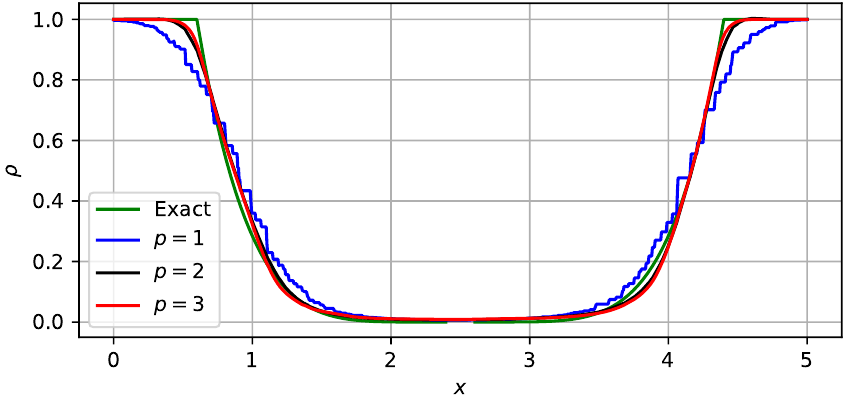
Figure 7. Comparison between solutions of ρ ( t = 0.4 ) in Problem 3.